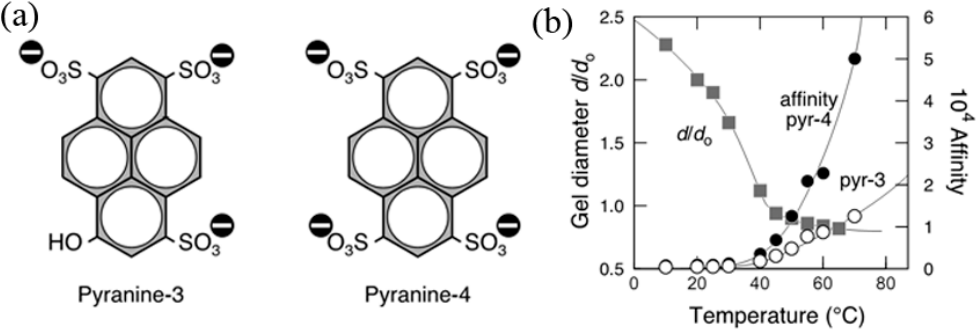
Figure 2. ( a ) The chemical structures of pyranine-3 and pyranine-4; ( b ) The affinity of the gels to pyranine-3 and pyranine-4 as a function of temperature. Reprinted with permission from Reference 94. Copyright 1999, Science.